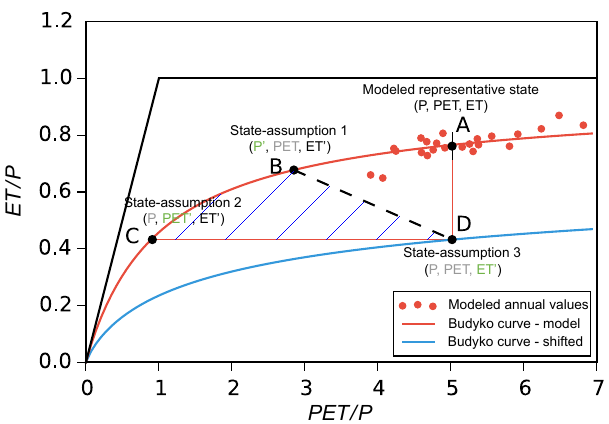
Figure 3. The illustration of the ORCHIDEE-Budyko framework. Point A represents the average state among the modeled annual val- ues (with the land surface model ORCHIDEE), and the red curve is the simulated Budyko curve following the modeled state. Points B, C and D represent the representative state with the P , PET and ET shifted, respectively, with different assumptions to meet the discharge observations. A shifted Budyko curve (blue) is obtained crossing the point D, which indicates a new state of the model struc- ture. The new points of B and C still stay on the original Budyko curve, indicating that the model structure remains the same and the changes only relate to forcing variables. The shaded area is the area among the three shifted